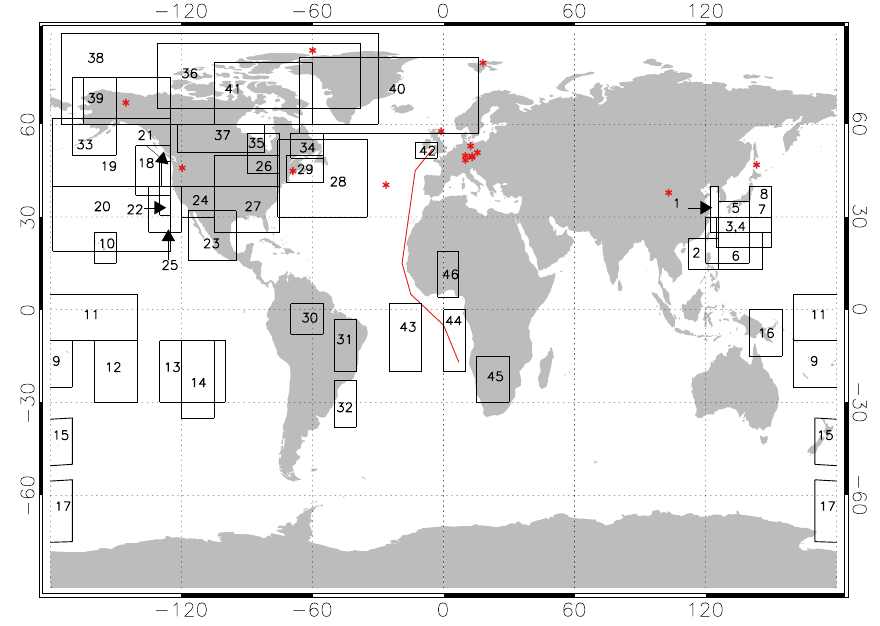
Fig. 1. Locations of PAN observations used in our analysis (Table 2): surface sites (red asterisk); aircraft missions (black boxes) with region numbers indicated; and one cruise (red line).